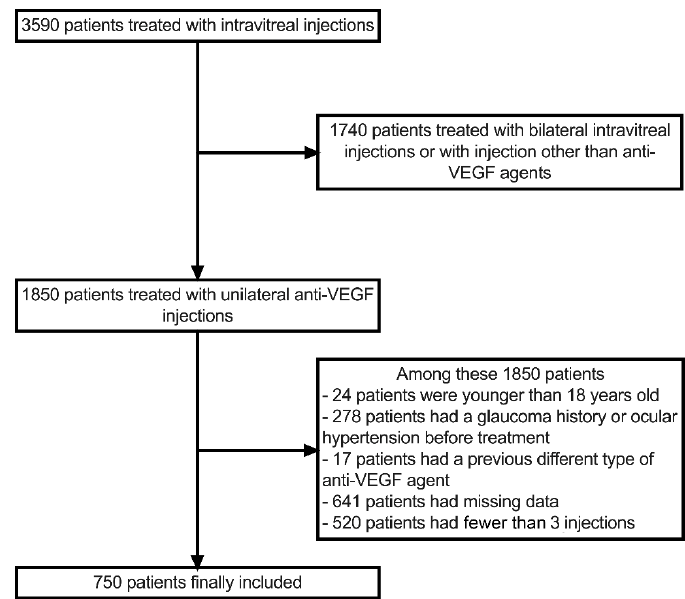
Figure 1. Flowchart of the study.